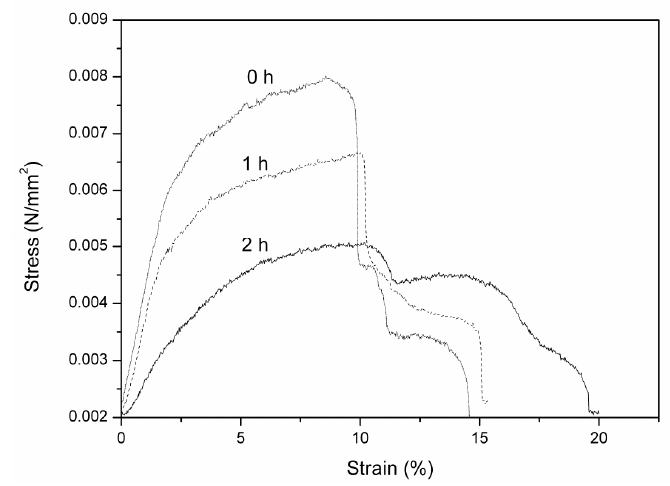
Figure 7. Assays of stress–strain of hydrolyzed PAN membranes.